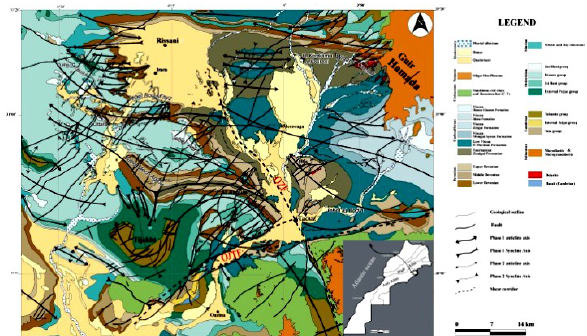
Fig.1. lithological outcrops and Structural schema of the study area (South Ougnat-Ouzina axis and Southeast Tafilalet Basin), modified after (ALVARO et al., 2014b; BENHARREF et al., 2014b) and assembled from Irara and Merzouga sheets of the geological map of Morocco at